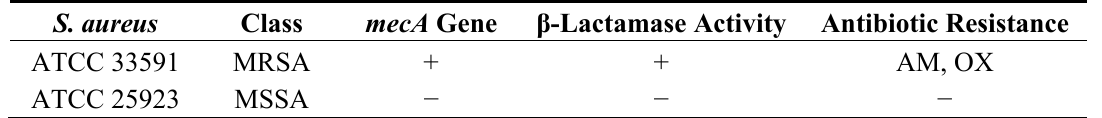
Table 1. Determination of the mecA gene status of the Staphylococcus aureus strains used in this study. S. aureus Class mecA Gene β -Lactamase Activity Antibiotic Resistance ATCC 33591 MRSA + + AM, OX ATCC 25923 MSSA − − − +, positive; − , negative; AM, ampicillin; OX,